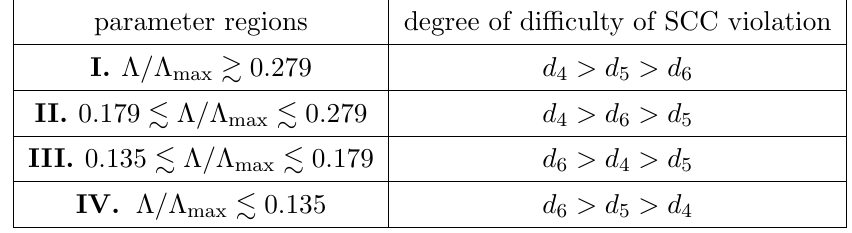
Table 1 . Comparison of (cid:3) = (cid:3) max with respect to the degree of di(cid:14)culty of SCC violation in d = 4 ; 5 and 6-dimensional RNdS